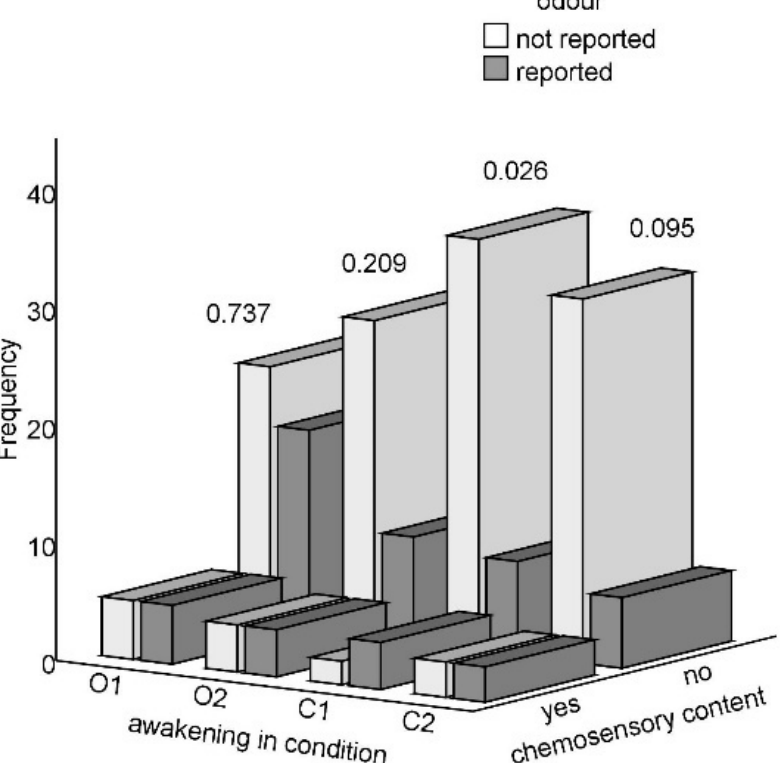
Figure 1. Absolute frequencies of sleep mentation reports involving or lacking chemosensory con- tent across the four awakenings, categorised according to odour detection (hit/miss; in O1 and O2) or belief about odour perception (false alarm/correct rejection; in C1 and C2); p -value for a chi-square test is shown for each awakening.